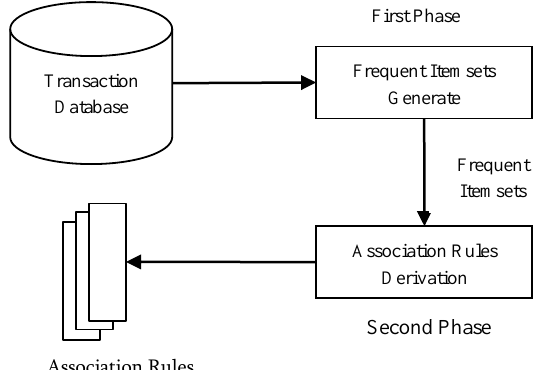
Figure 1. Association rule